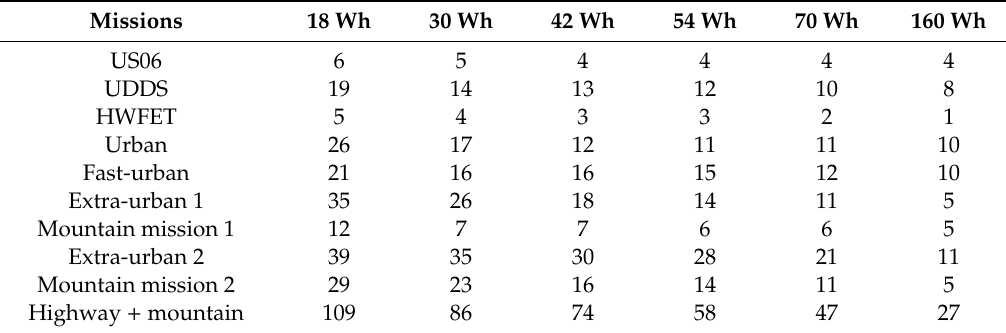
Table 3. Spark-ignition engine number of starts while speed is above Upper Speed Limit (USL) as a function of Normal Zone (NZ) sizing (i.e., NZ Wh). Values approximated to the nearest integer.